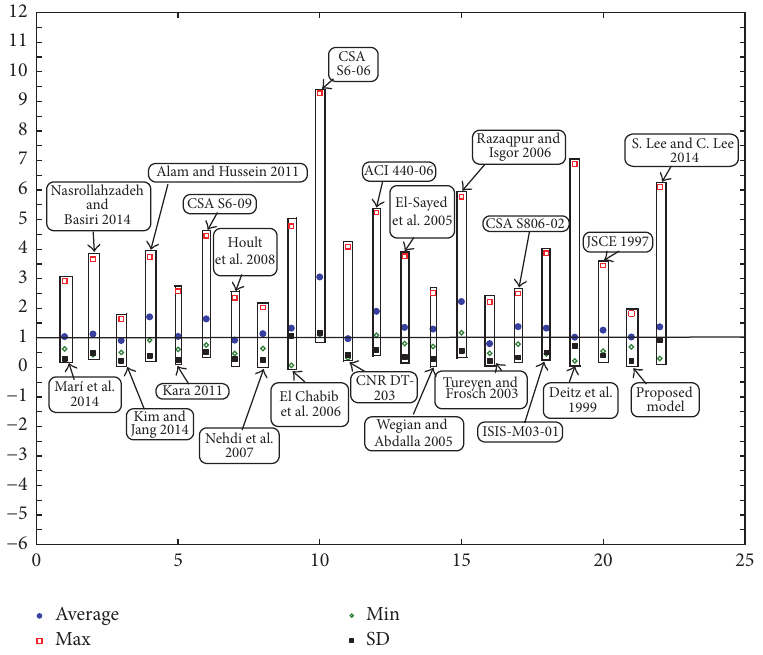
Figure 8: Statistical parameter comparison of available models.